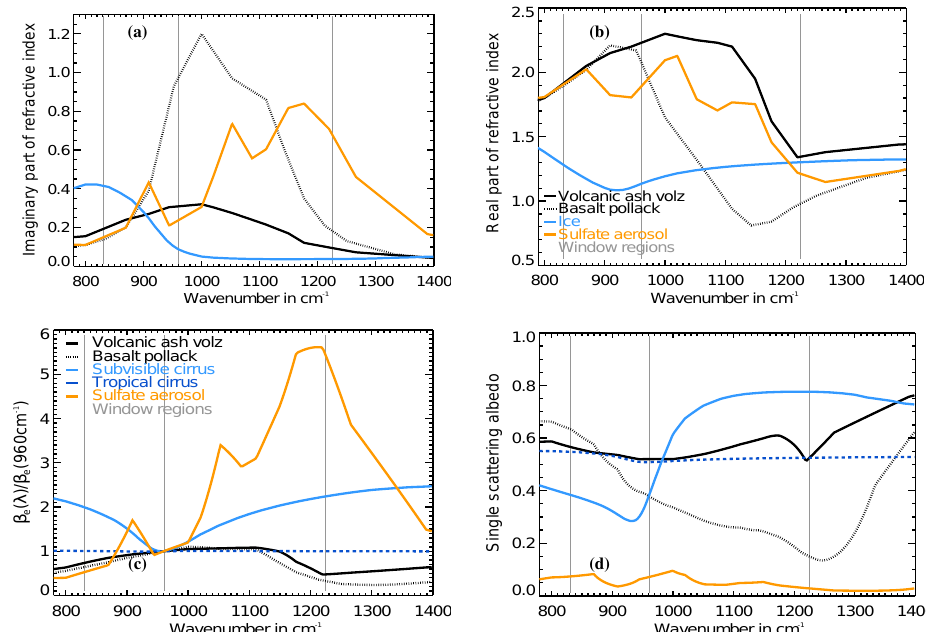
Figure 3. Microphysical properties of sulfate aerosol, ice, and two types of volcanic ash. (a, b) Complex refractive indices and their optical properties. (c) Extinction coefficient. (d) Single scattering albedo. The vertical lines indicate atmospheric window